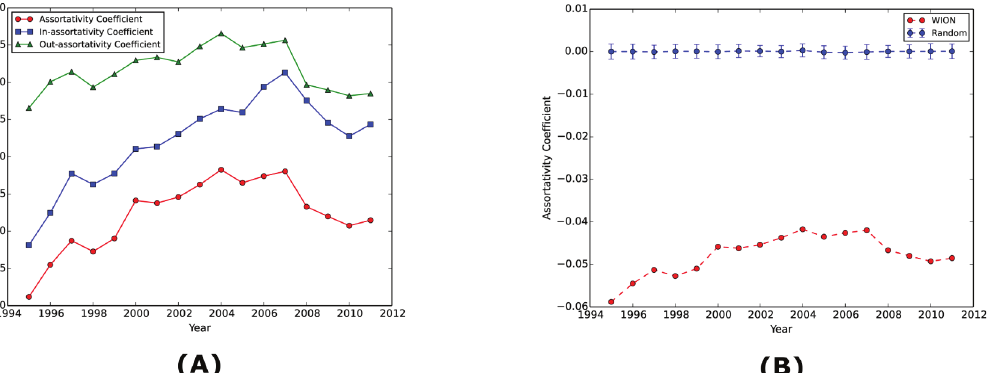
Fig 3. Assortativity of the WION over time. In Panel (A), from top to bottom, we show the over time out-degree assortativity, in-degree assortativity, and total-degree assortativity, respectively. Panel (B) compares the total-degree assortativity calculated from the original WION with that calculated from its random counterpart which preserves the degree distribution of the original network. For each year the random counterpart is simulated for 50 times and the 95% confidence interval is shown. Therefore, even with small magnitude, the assortativity coefficients are nevertheless statistically